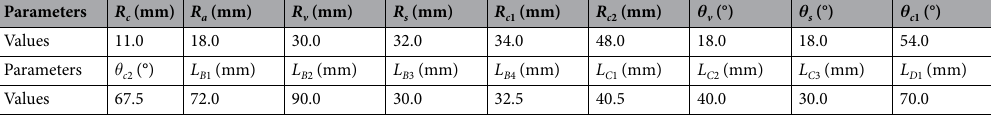
Table 3. Structure parameters of the ten-cavity RM.